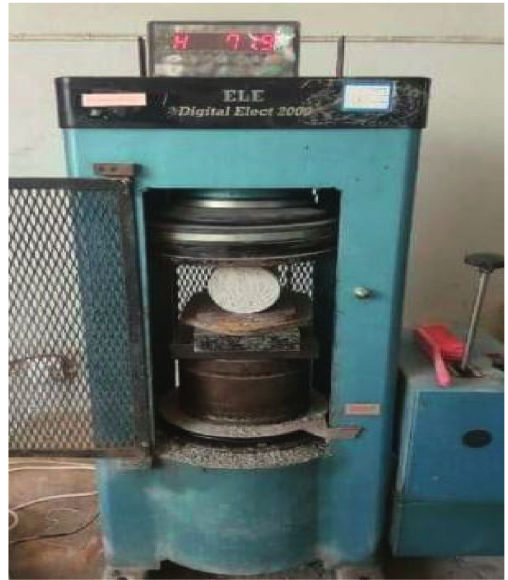
Figure 5: Splitting tensile strength test.